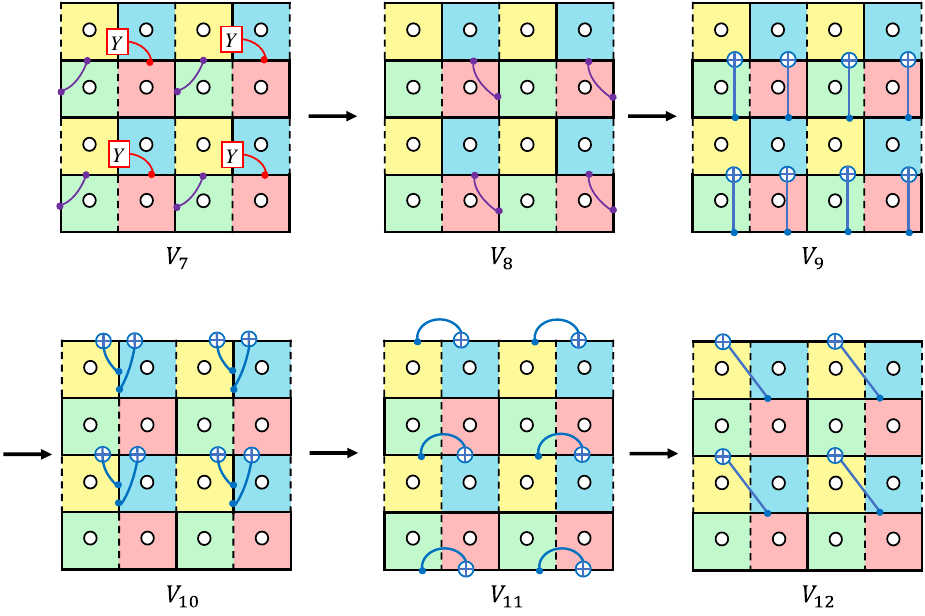
FIG. 8. The finite-depth Clifford circuit to construct bosonization with r = 1.25. The depicted unitaries are V 7 , V 8 , V 9 , V 10 , V 11 , V 12 (from top left to bottom right). The GLU disentangler is V SC = V 12 V 11 V 10 V 9 V 8 V 7 . After conjugation by the unitary operator V SC , a part of the stabilizers in Eq. (19) becomes a single Pauli matrix, which can be removed from the